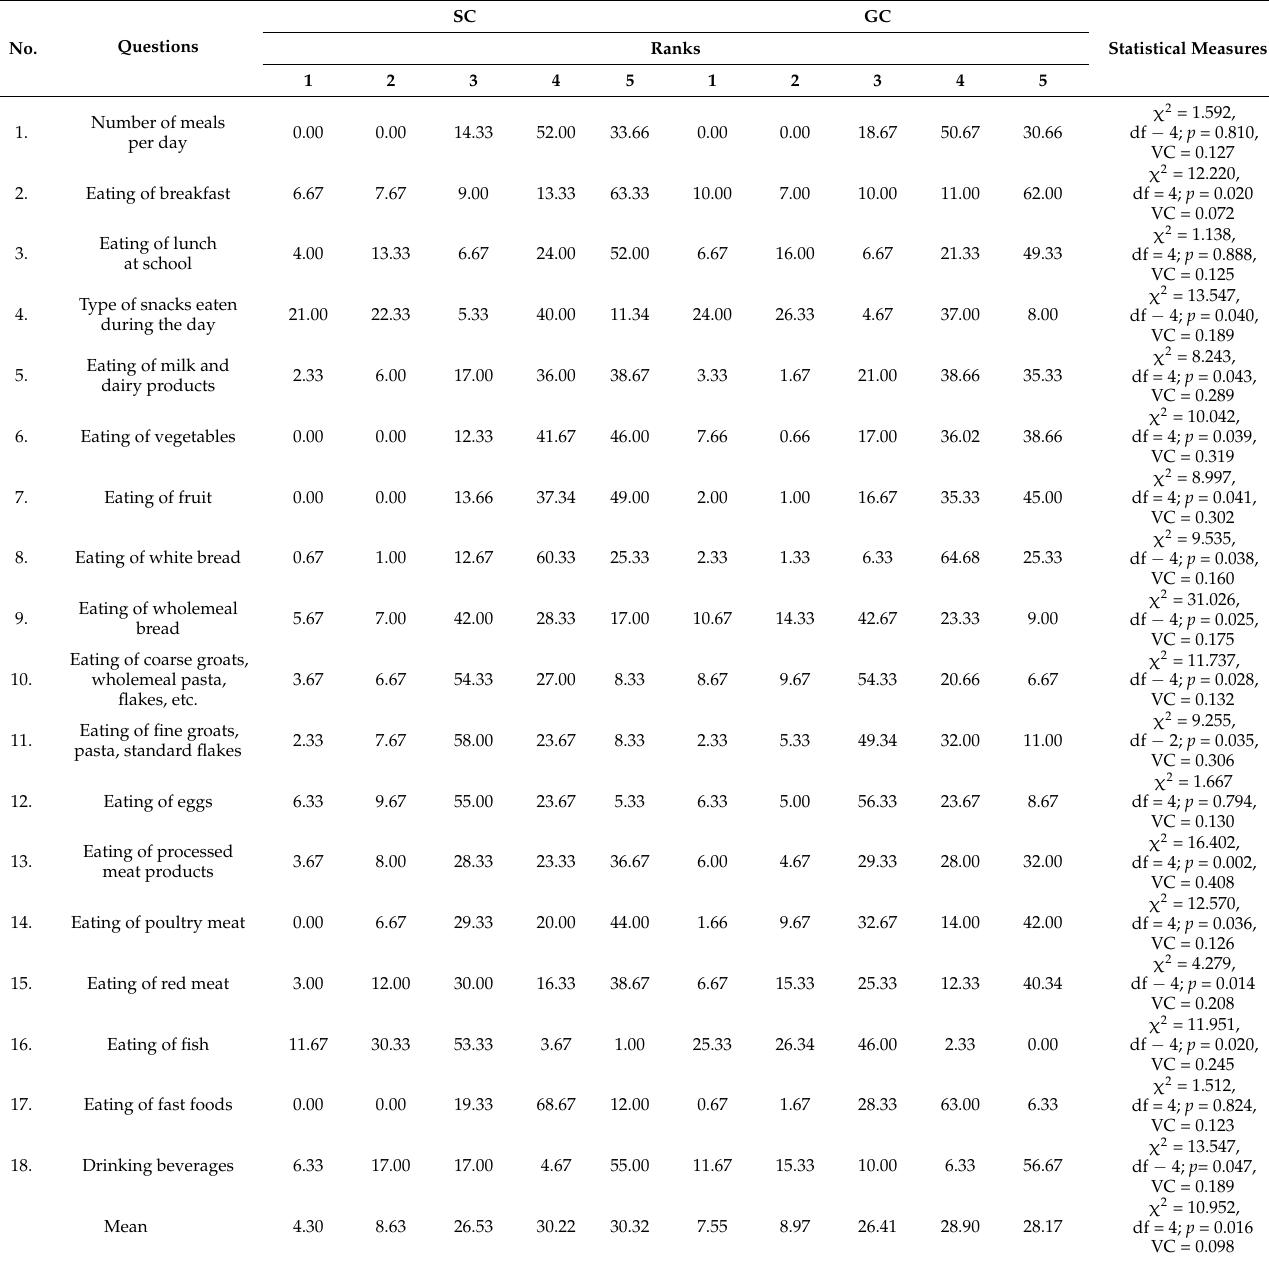
Table 1. Eating behaviour of SC and GC children, average scores from the entire study period, % of particular ranks in the